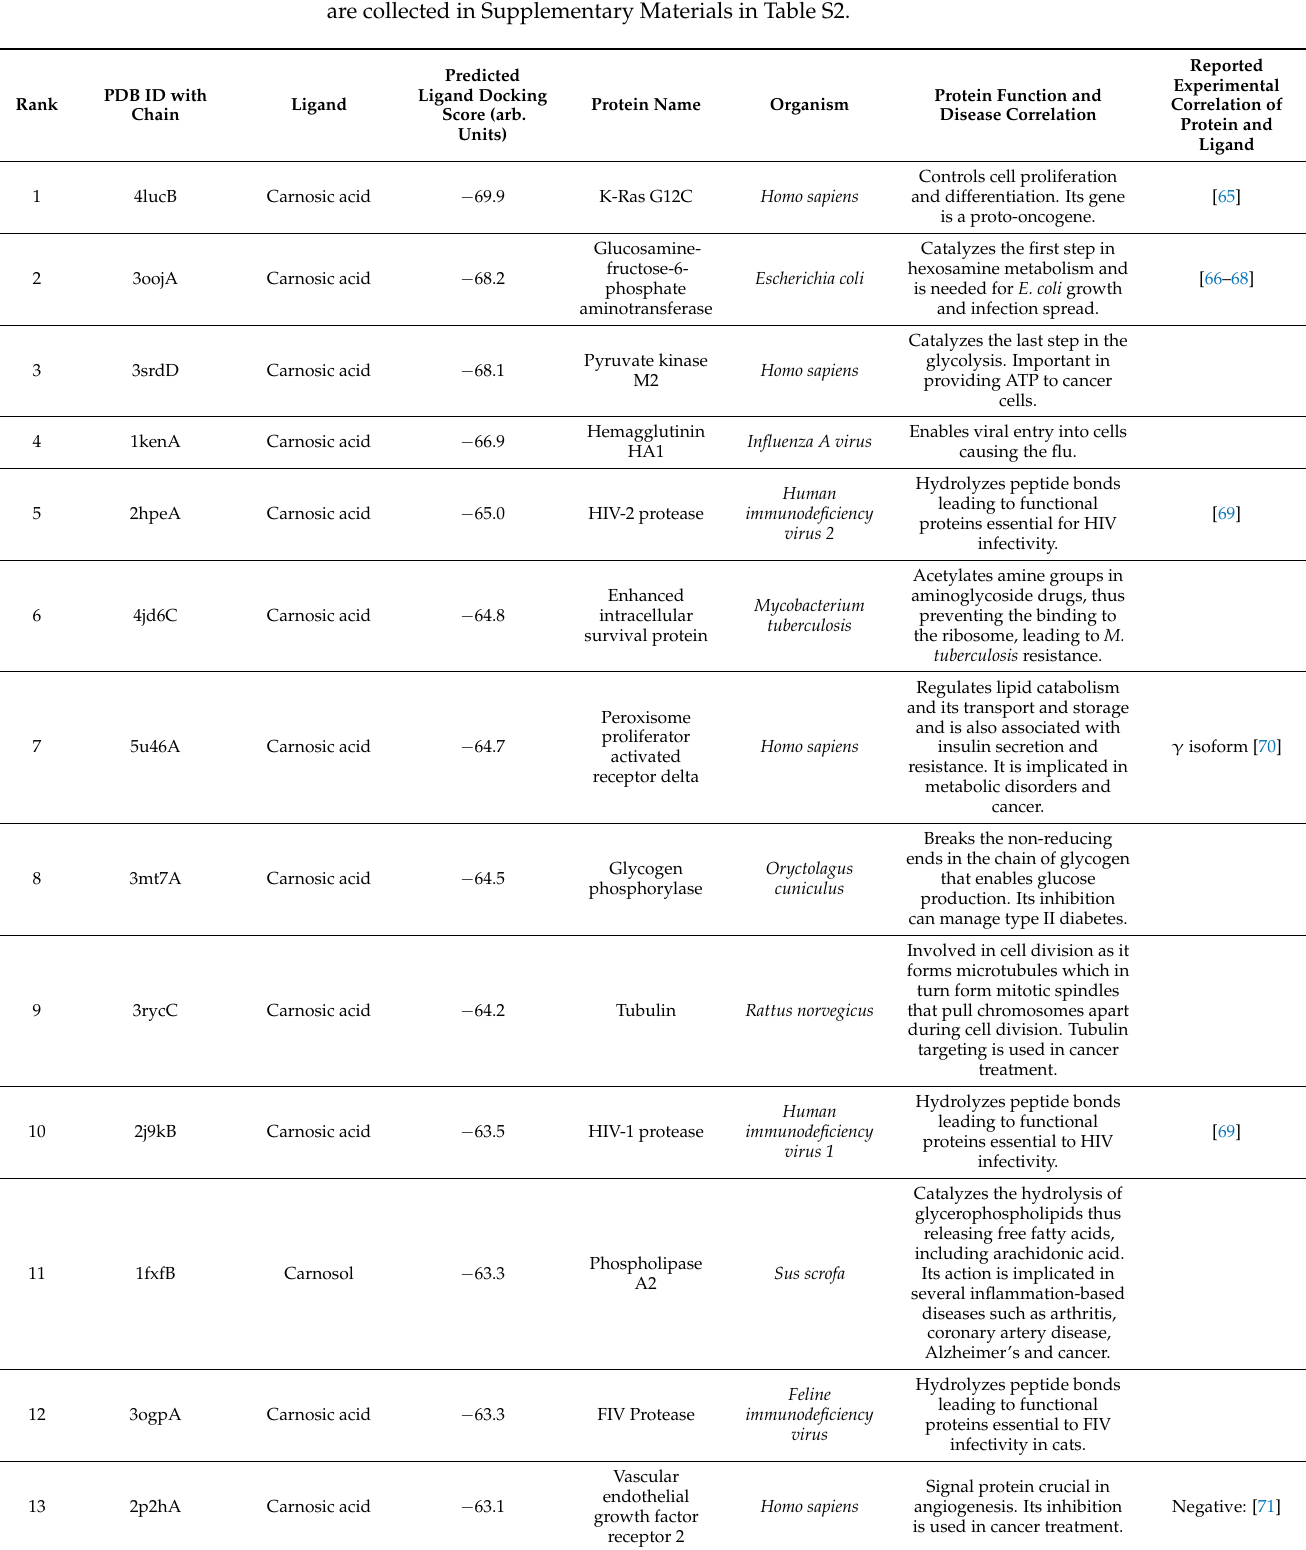
Table 1. Best scoring human, mammalian, and pathogen protein targets of rosemary diterpenes carnosic acid, carnosol, and rosmanol. Docking scores independent of the organism or type of protein are collected in Supplementary Materials in Table